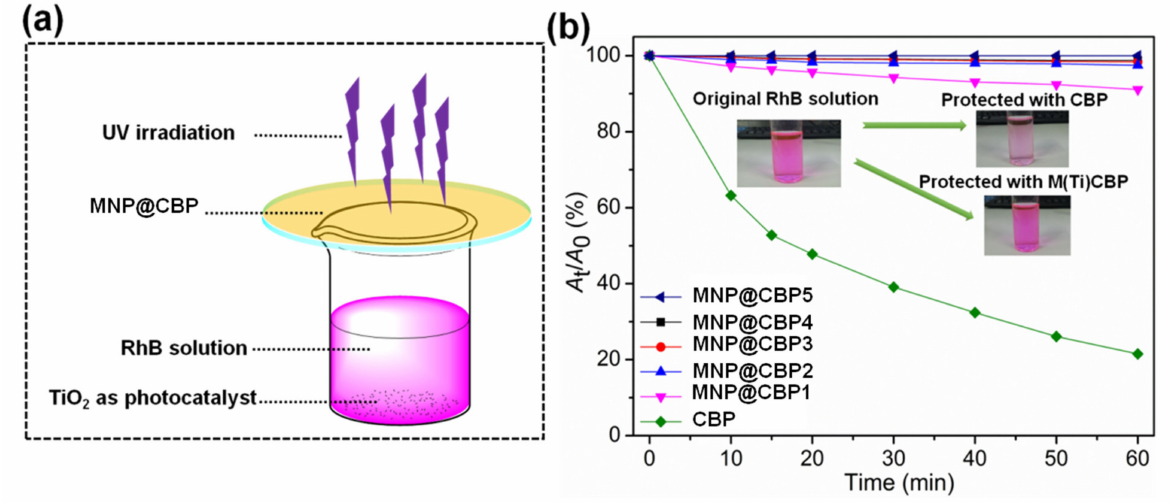
Figure 7. ( a ) Experimental schematic diagram of photodegradation of RhB based on MNP@CBP. ( b ) Photodegradation curves of RhB solutions protected by MNP@CBPs. The inserted photographs: the original RhB solution, and the solution protected with neat CBP and MNP@CBP,